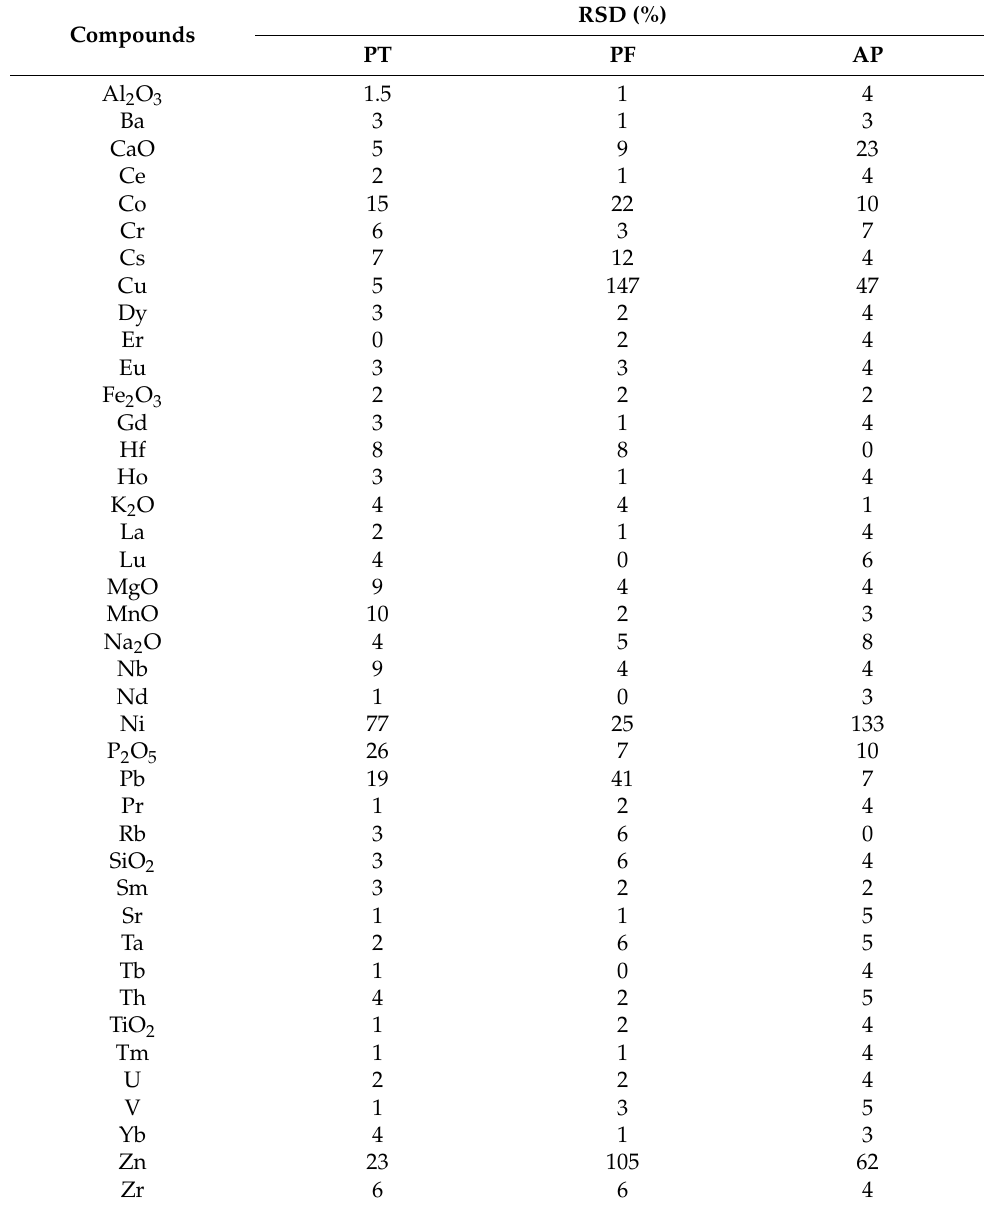
Table 3. The repeatability (RSD%) of the components for each type of paste (PT, PF, AP).